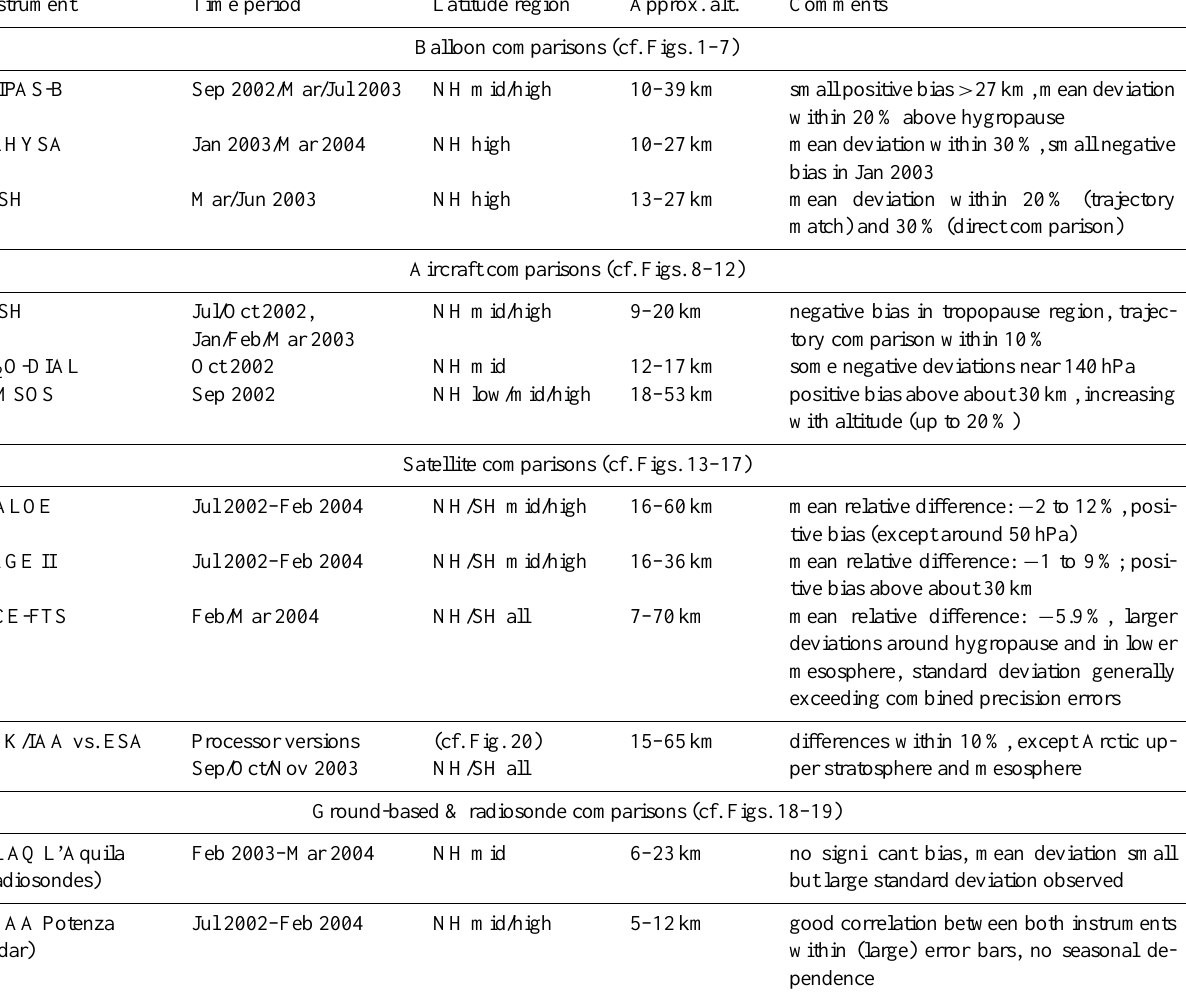
Table 5. Quality of the agreement between MIPAS H 2 O data and independent observations carried out by different instruments (coincidence criterion: 300km and 3h). Time periods, latitudinal regions, and approximate altitudes of the intercomparisons together with comments